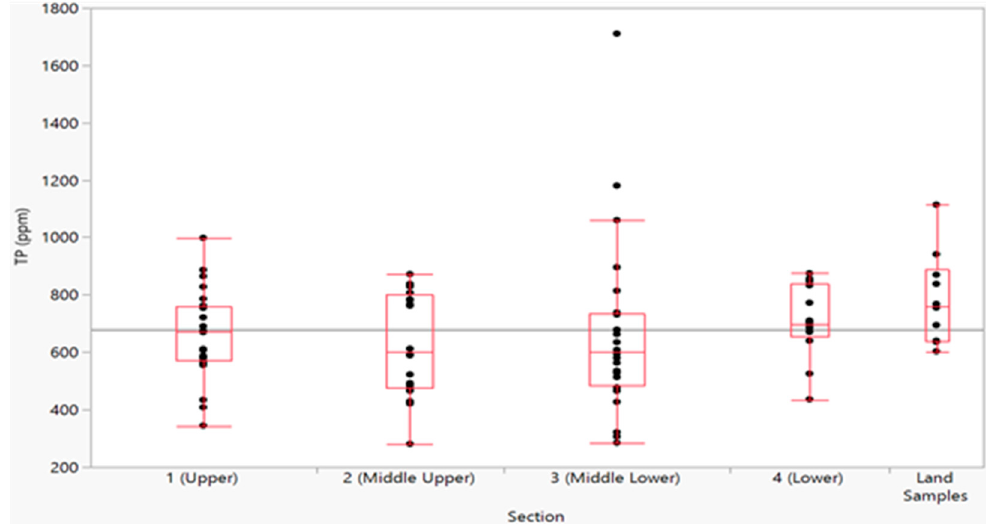
Figure 7. Box plots of total phosphorus measurements for each of the sections shown in Figure 6 and land samples.